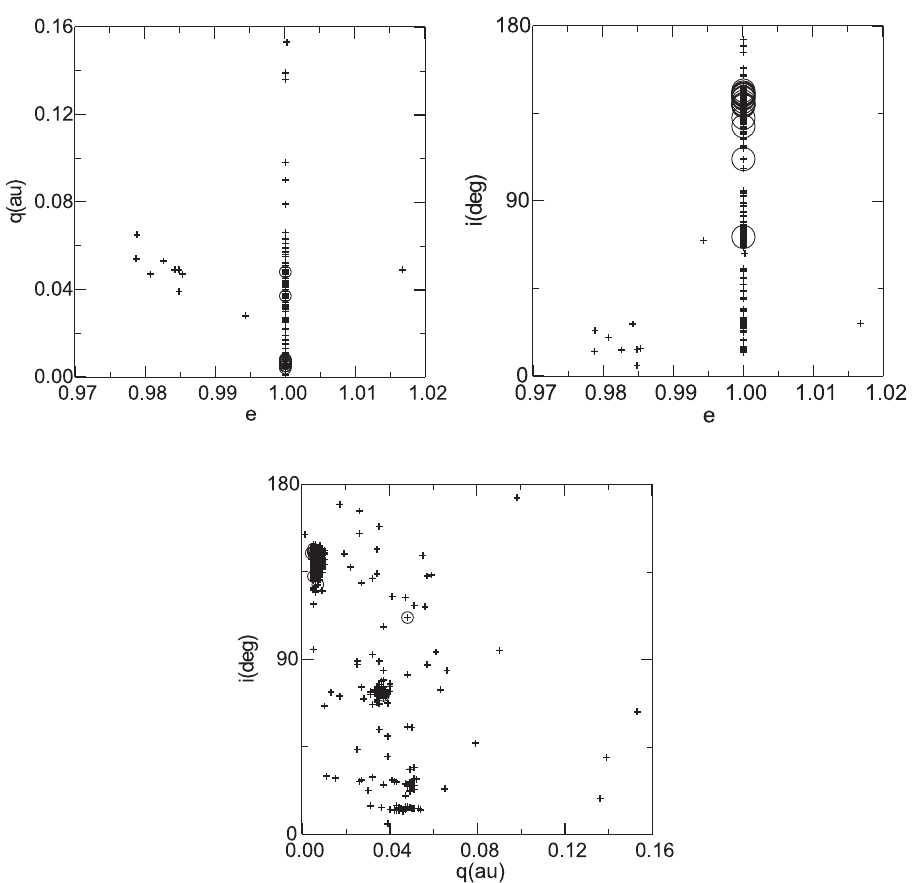
Figure 1: Positions of discovered SOHO comets at the Vilnius Observatory – circles, on the plane of all discovered SOHO comets – crosses, as of 2021 Dec.